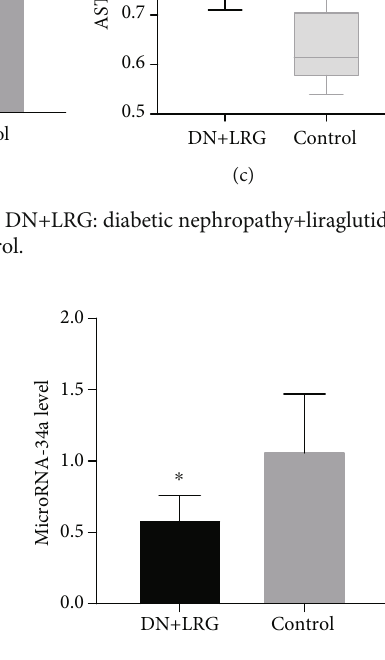
Figure 5: Expression of microRNA-34a in the kidneys. Control: diabetic nephropathy group; DN+LRG: diabetic nephropathy +liraglutide group. ∗ P < 0 : 05 vs. the